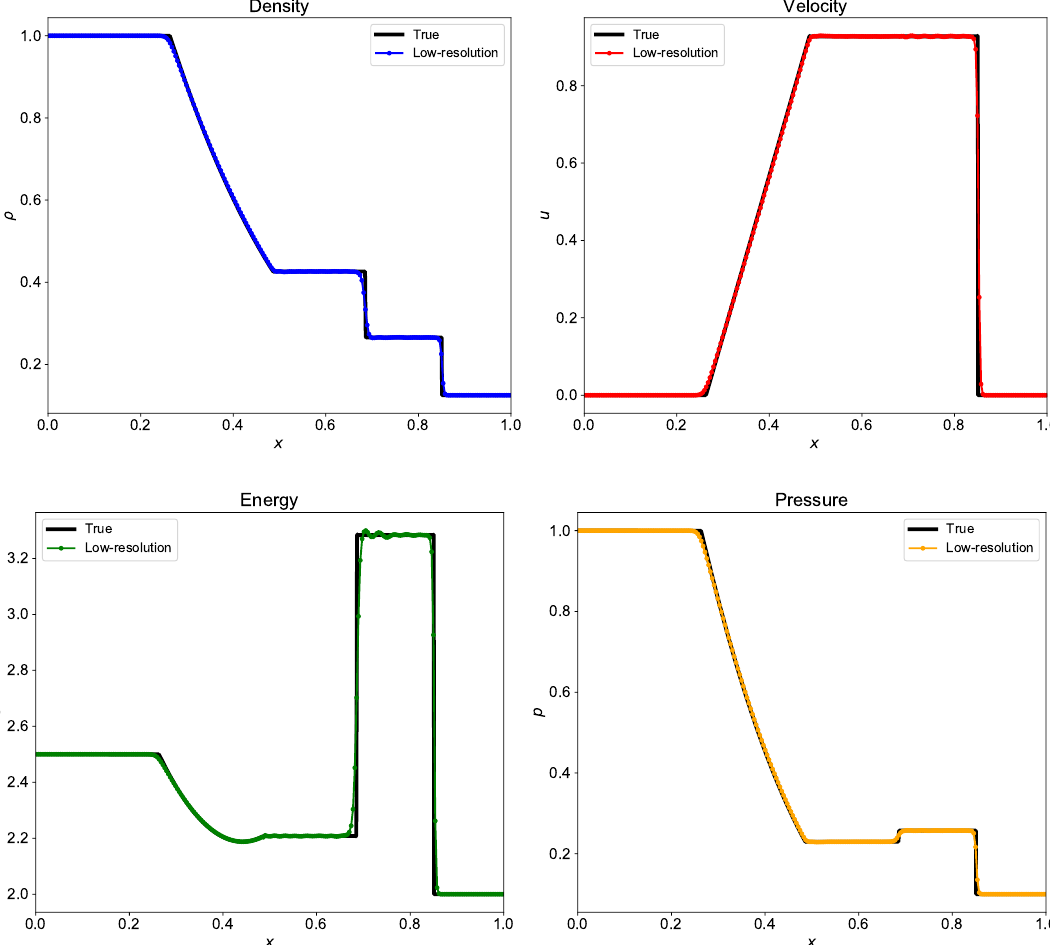
Figure 12. Evolution of density, velocity, energy, and pressure at t = 0.2 for the shock tube problem computed using Riemann solver based on Roe averaging. The true solution is calculated with N = 8192 grid resolution with ∆ t = 0.00005 and the low-resolution results are for N = 256 grid resolution with ∆ t =